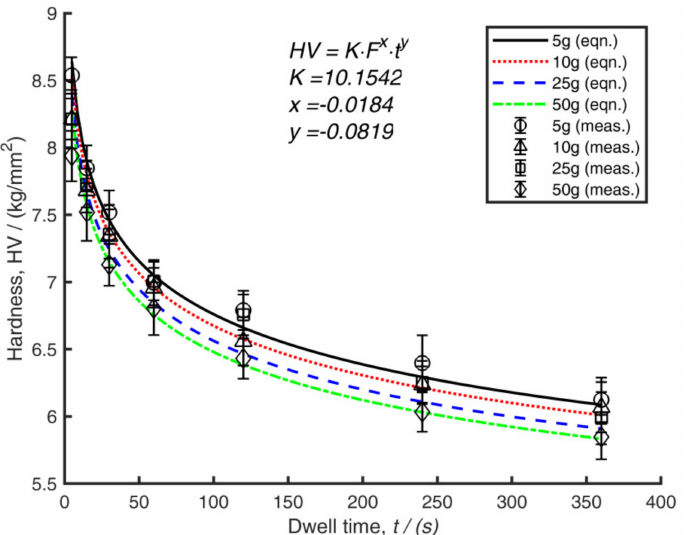
Figure 9. Comparison of the measured and predicted hardness versus dwell time over all four load levels. Lines of best fit are